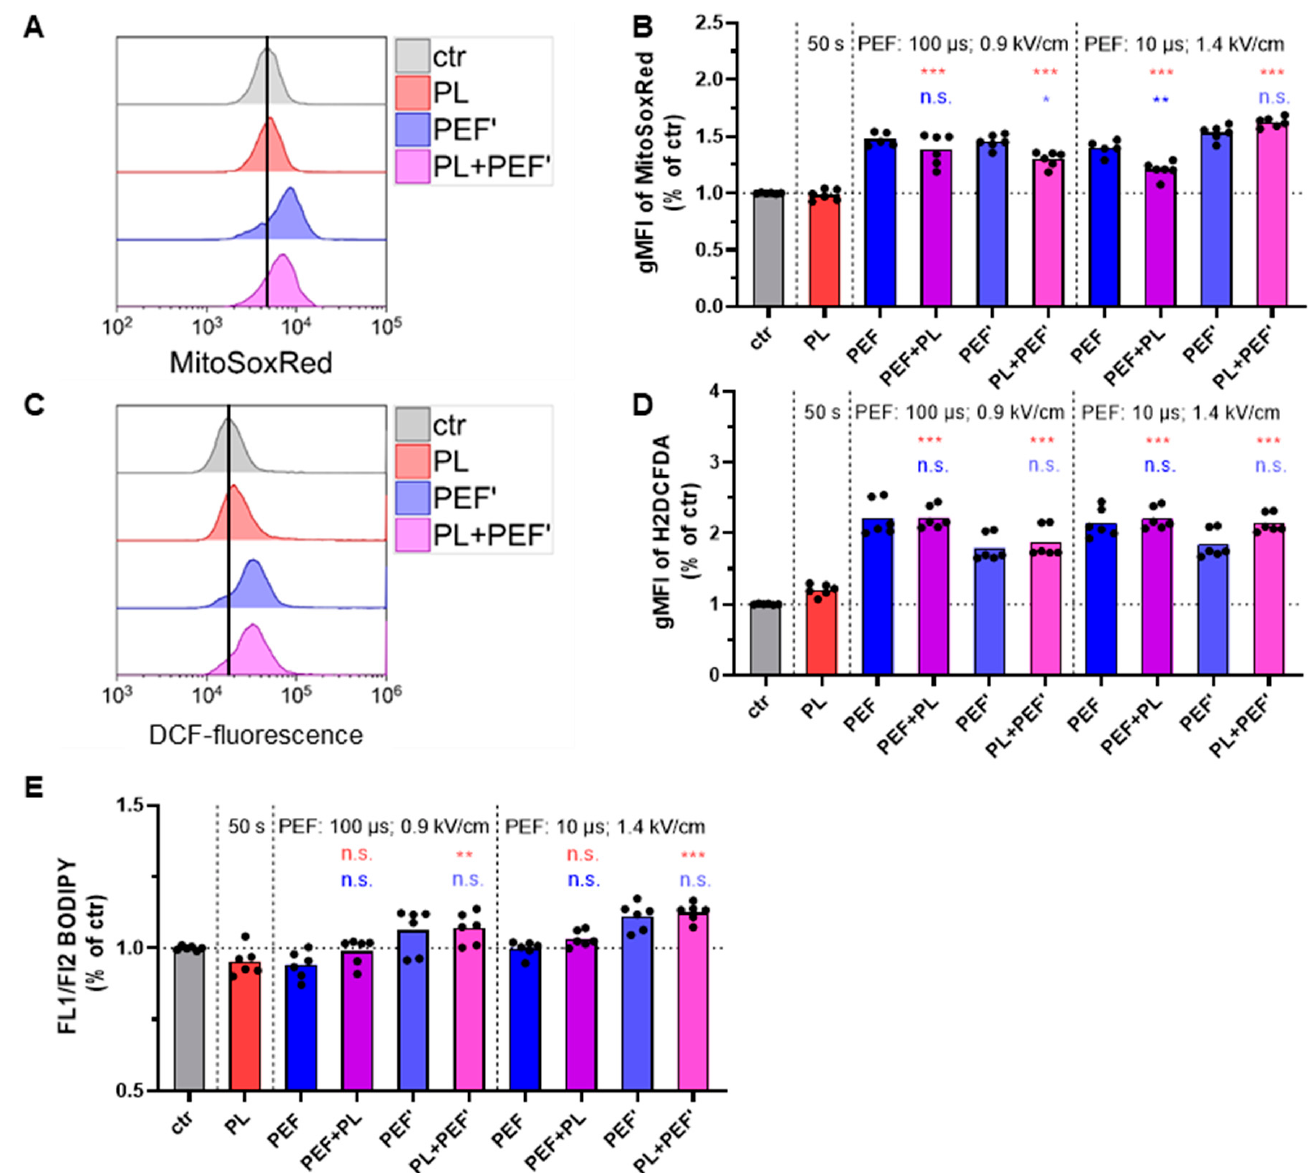
Figure 4. Intracellular ROS in Jurkat cells directly after applying plasma and PEF. The ROS level was analyzed via MitoSOX Red ( A , B ), indicating mitochondrial superoxide CM-H2DCFDA ( C , D ), indicating cytosolic ROS, and BODIPY 581/591 C11, indicating lipid peroxidation ( E ). Data are shown as one representative ( A , C ) or mean from three independent experiments with several replicates each ( B , C , E ). One-way ANOVA with Turkey’s multiple comparison test was performed (*: p < 0.05, **: p < 0.01, and ***: p < 0.001). ctr: control; PL: plasma; PEF: pulsed electric field; PEF’: cells were seeded into 96-well plates before being transferred into cuvettes; n.s.: not significant; gMFI: fluorescence intensity of the geometric mean; FL: fluorescence channel.